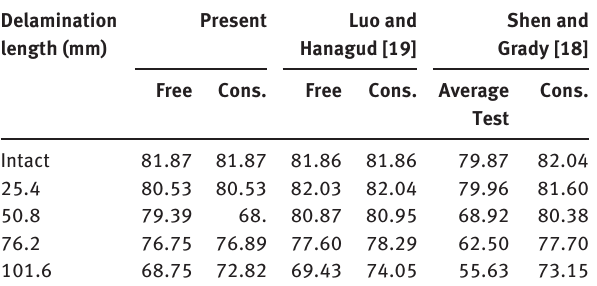
Table 6 Second frequencies (Hz) for the LCB with central delamina- tion (at interface 1).